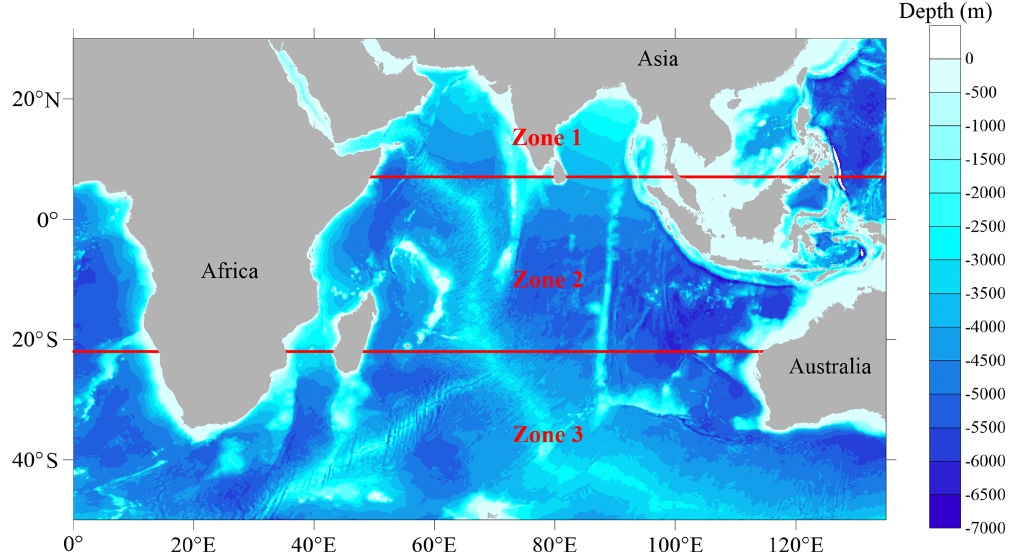
Figure 1. Bathymetric map (color codes in meters) in the Indian Ocean. Red lines (7 ◦ N and 22 ◦ S) show the zone partition in the present study. (cid:82)(cid:82) η sw exp { i (k 1 x + k 2 y − ωt) } d k 1 d k 2 (here the superscript